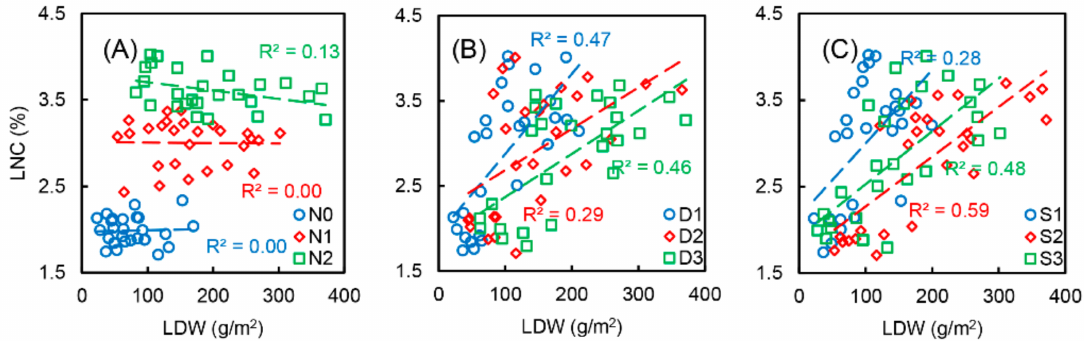
Figure 10. Correlation between LDW and LNC under different nitrogen application rates ( A ), row widths ( B ) and phenological periods ( C ); N0, N1, and N2 represent the nitrogen application rate of 0, 180, and 360 kg/hm 2 , respectively; D1, D2, and D3 represent row widths of 50, 35, and 20 cm, respectively; S1, S2, and S3 represent the jointing stage, booting stage, and heading stage, respectively.